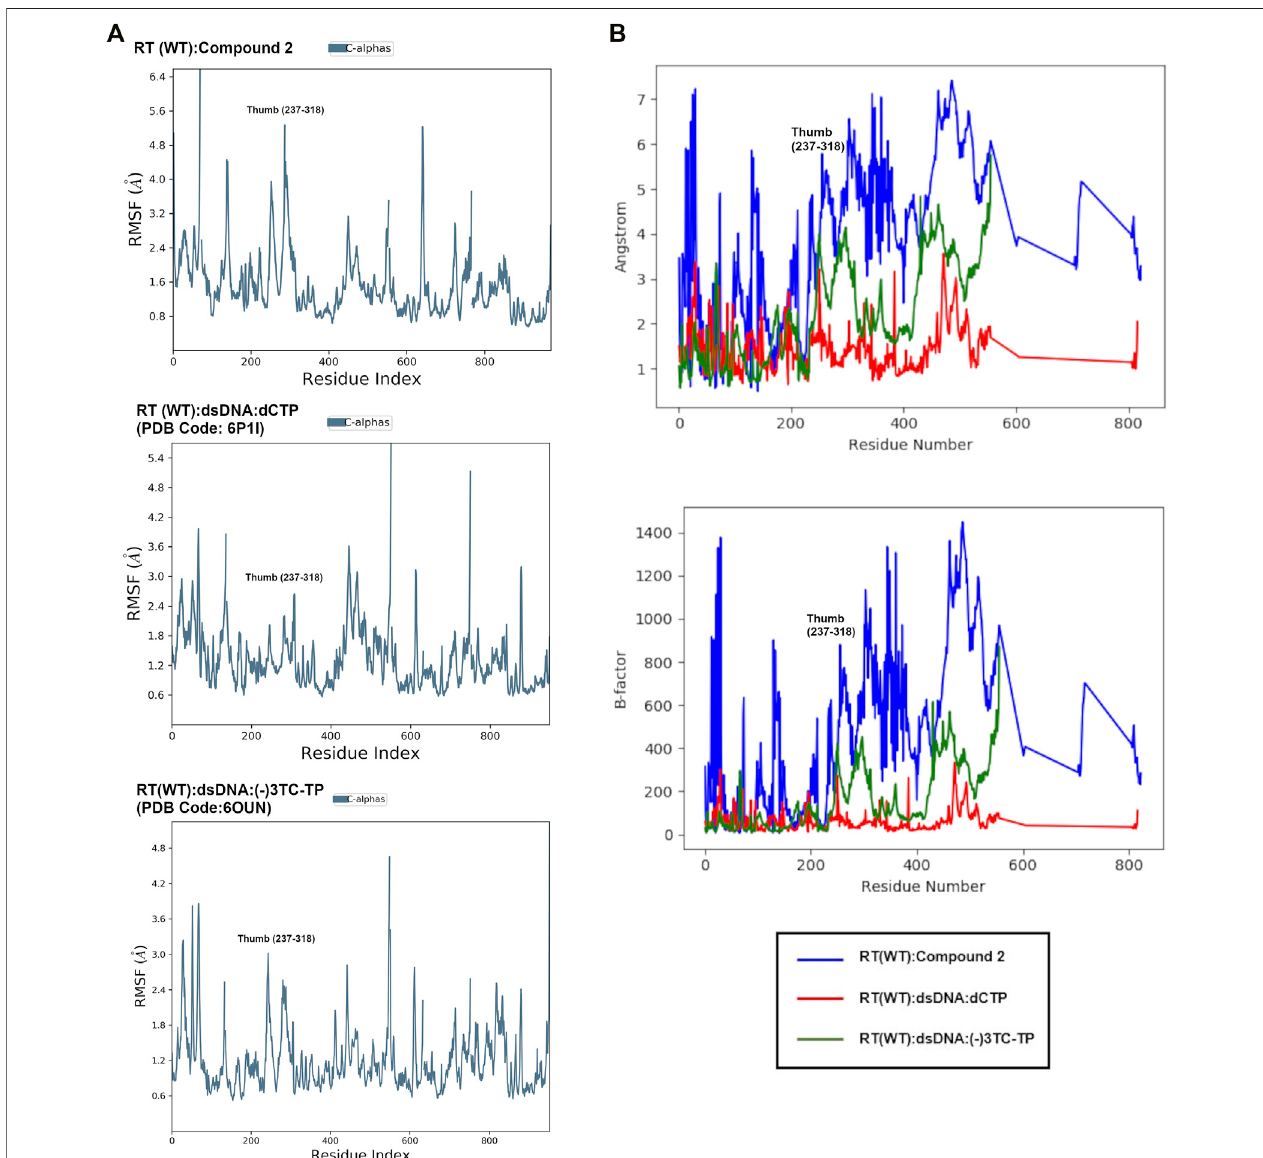
FIGURE 8 | (A) : Comparison of root mean square fl uctuation (RMSF) values from MD in Å per residue in RT (WT): 2 , RT (WT):dSDNA:dCTP (PDB: 6P1I), and RT (WT):dsDNA:(-)3TC(PDBcode:6OUN).RMSFvaluesinÅwerecalculatedusingtheRMSFequationin SupplementaryFigureS1 usingtheinitialstructure(snapshotor frame 0) as reference. The RMSF values represent the average RMSF for each residue during the 24 ns simulation. (B) : Overlay of RMSF values for all 3 complexes in Å and scaled to structure B-factors. A noticeable difference in the thumb region of RT is observed when bound to NNRTI compound